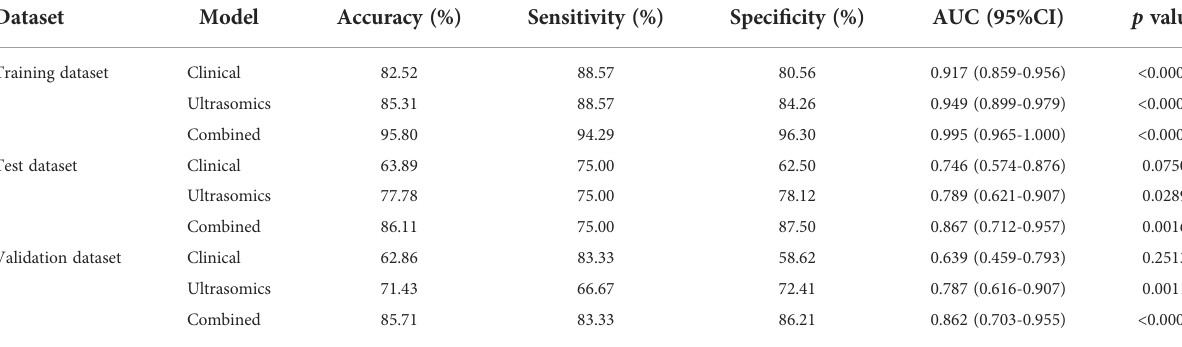
TABLE 2 The performance of training dataset, test dataset and veri fi cation datase.